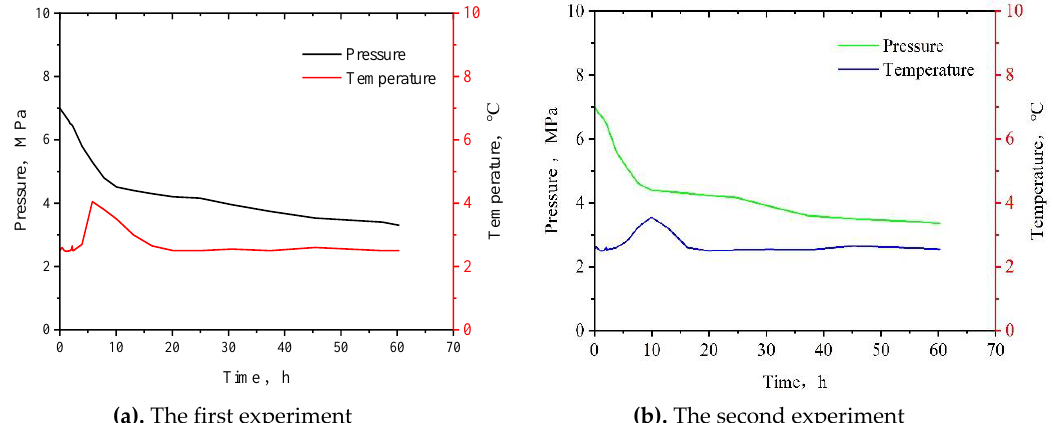
Figure 11. Temperature and pressure changes during preparation of hydrate by bubbling method.